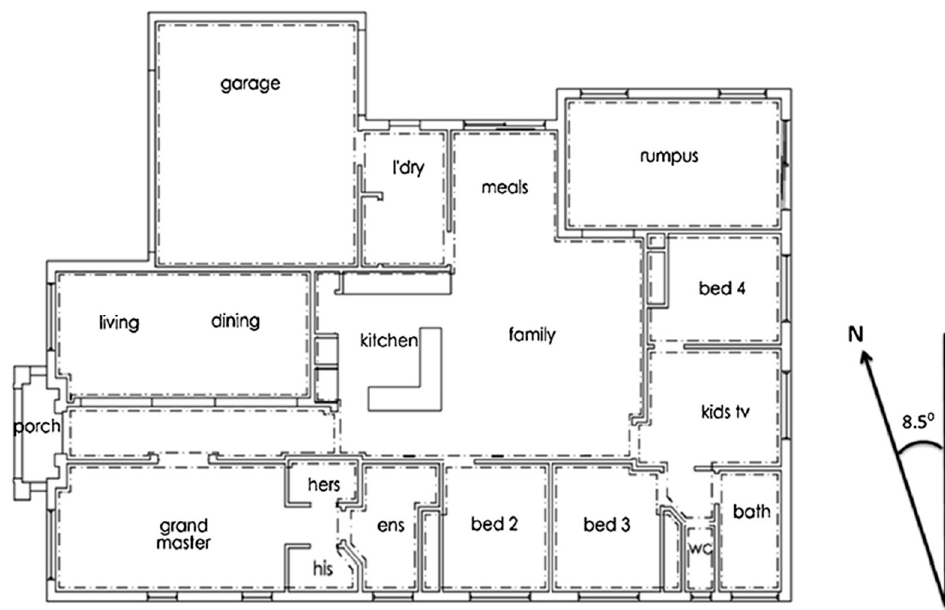
Figure 4. Floor plan of case study buildings. Table 2. Thermo-physical properties of building materials